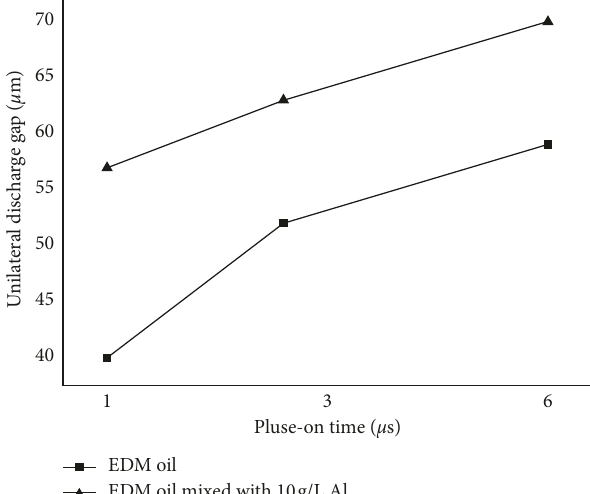
Figure 9: Pulse-on time dependencies of unilateral discharge gap between EDM oil and EDM oil mixed with 10g/L Al